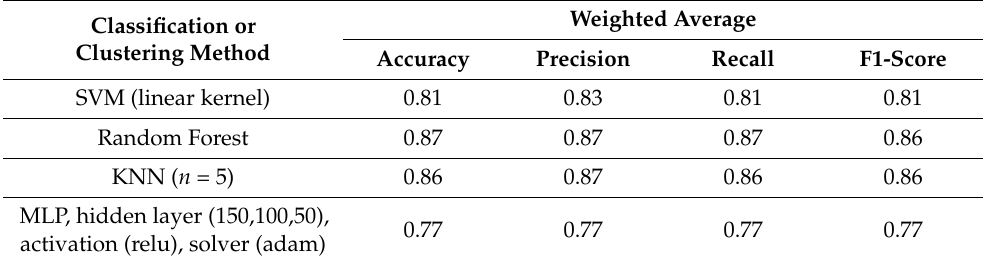
Table 6. Performance of different algorithms for RSSI_WSN data.